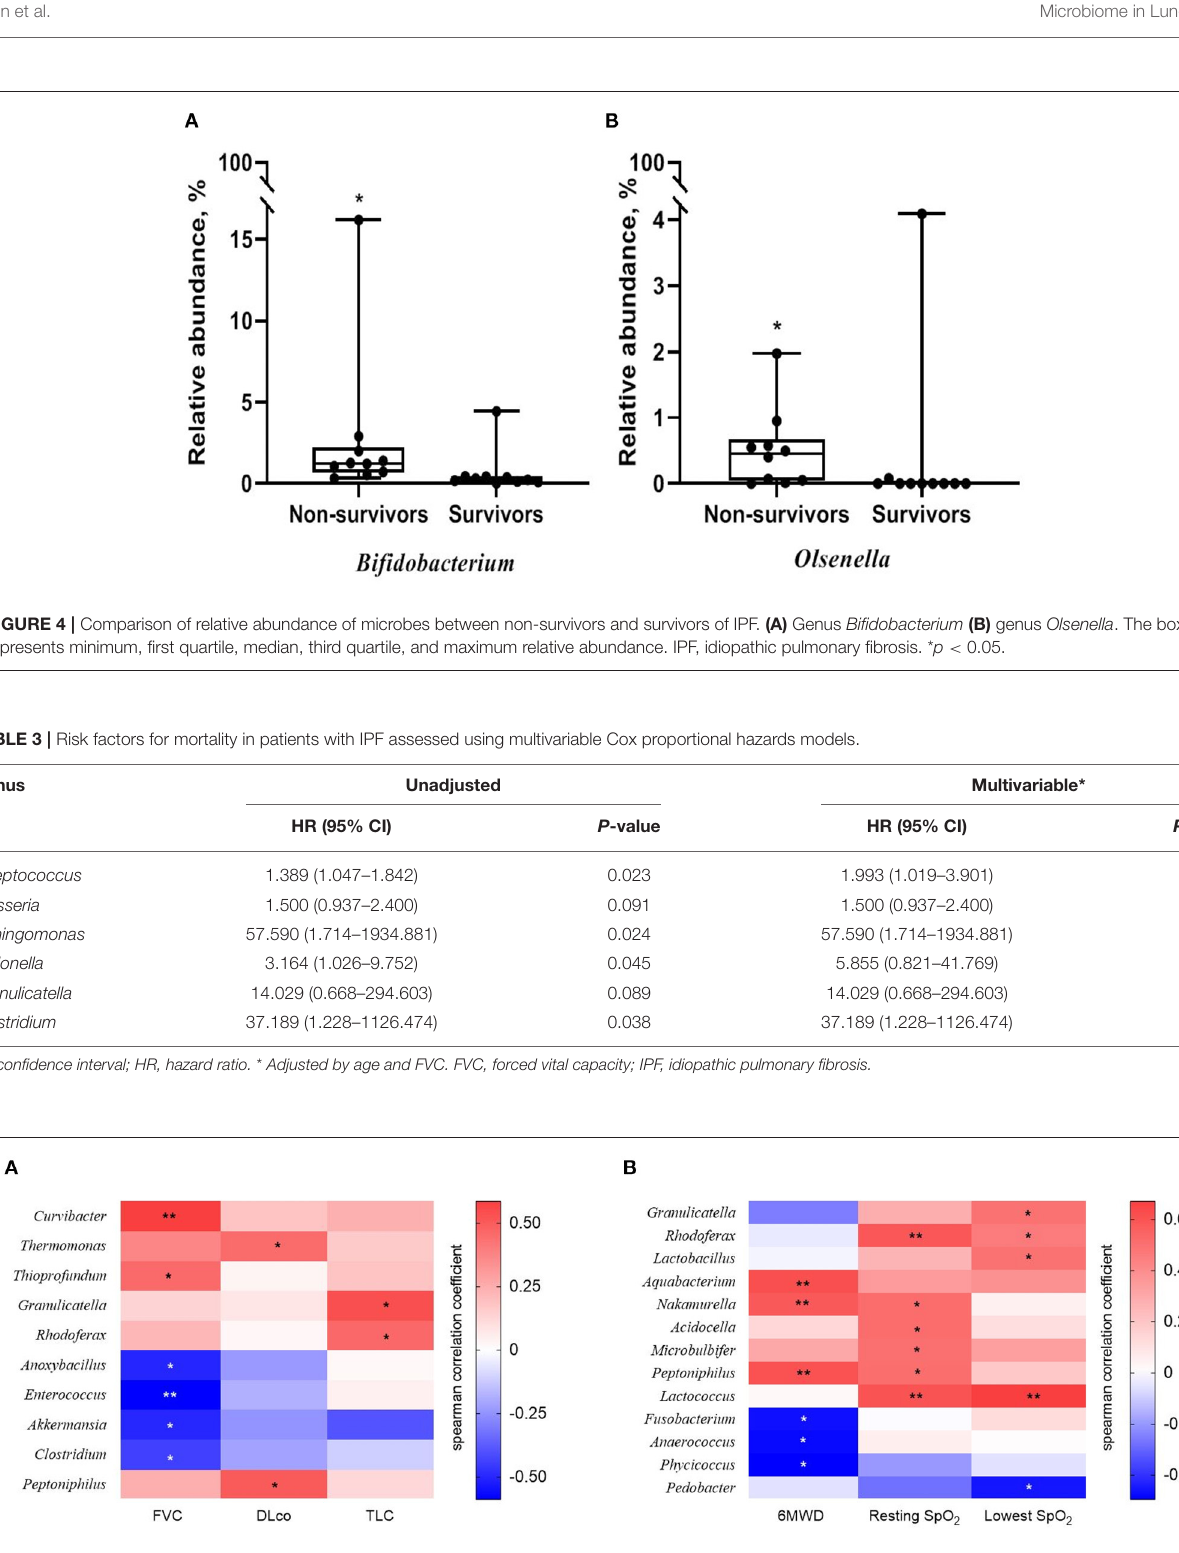
FIGURE 5 | The heatmap showing correlations between relative abundance of bacterial taxa and (A) lung function or (B) exercise capacity in patients with IPF. Spearman’s correlations between the relative abundances of the bacterial genera and lung function and exercise capacity at diagnosis were calculated. Blue: negative correlations; red: positive correlations. * p < 0.05, ** p < 0.01. DLco, diffusing capacity of the lung for carbon monoxide; FVC, forced vital capacity; IPF, idiopathic pulmonary fibrosis; TLC, total lung capacity. 6MWD, 6-minute walk test distance; SpO 2 , oxygen saturation.